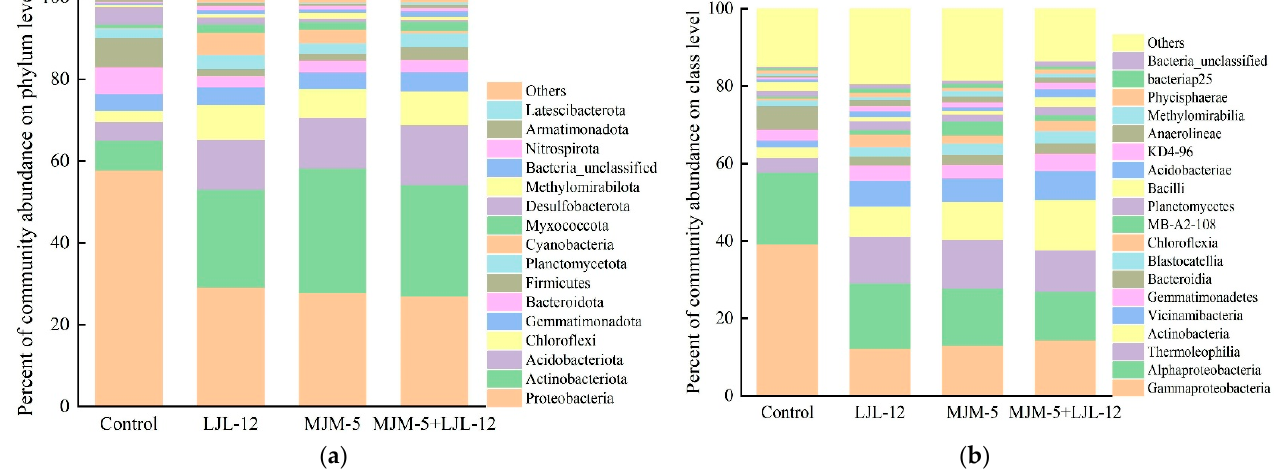
Figure 5. Bacterial community composition in the rhizosphere of alfalfa under Control, LJL-12, MJM-5, and MJM-5+LJL-12 treatments at ( a ) the phylum level (others: relative abundance < 0.1%) and ( b ) the class level (others: relative abundance <0.4%).